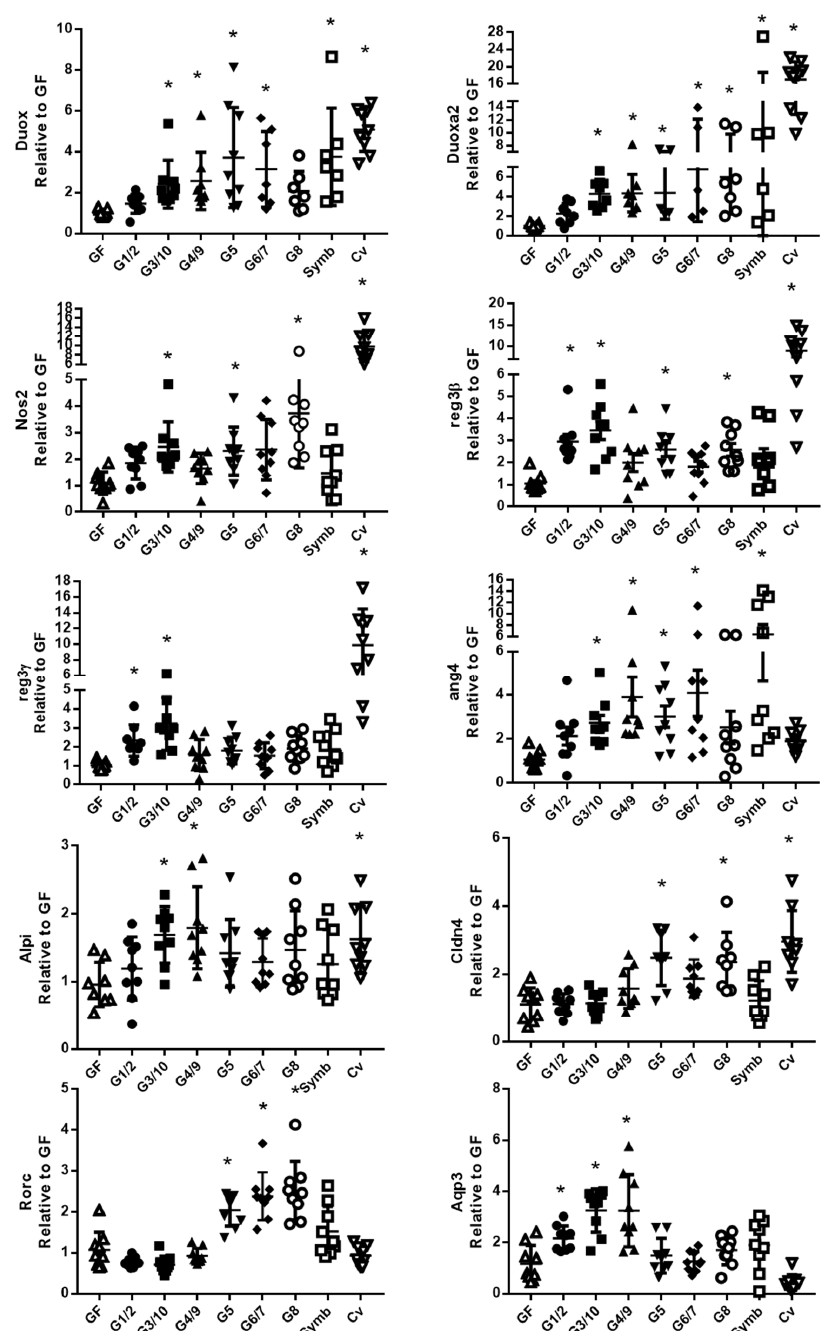
Figure 6. The six bacterial strains of Symbioflor2 ® modulate genes involved in several cell functions in the ileum. Relative gene expression was measured with single Taqman Assays for duox2 , duoxa2 , nos2 , reg3 β , reg3 γ , ang4 , alpi , cldn4, rorc , and aqp3 in the ileum of mice mono-associated with one of the six Symbioflor2 ® genotypes (G1 / 2, G3 / 10, G4 / 9, G5, G6 / 7, G8), inoculated with the Symbioflor2 ® product that contains the six genotypes (symb), in GF mice and in Cv mice; n = 9–10 mice / group. All values are presented as the means ± standard error of the mean (SEM). * indicates a statistical difference compared to GF mice (adjusted p -value <0.05).